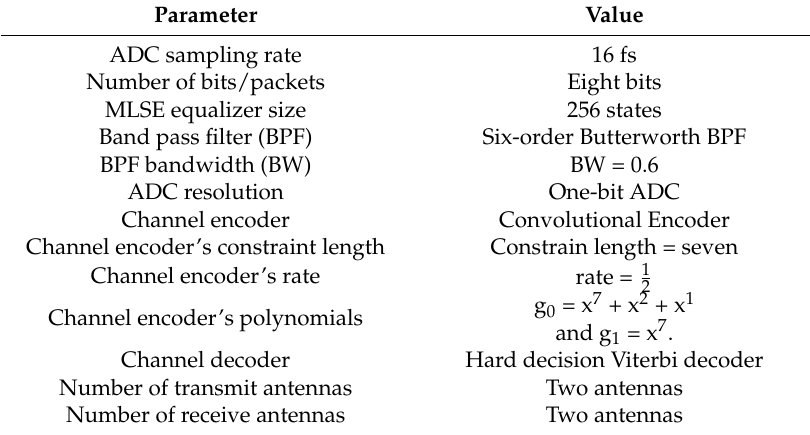
Table 1. Simulation Parameters. ADC: analog to digital converter, MLSE: maximum-likelihood sequence estimation.